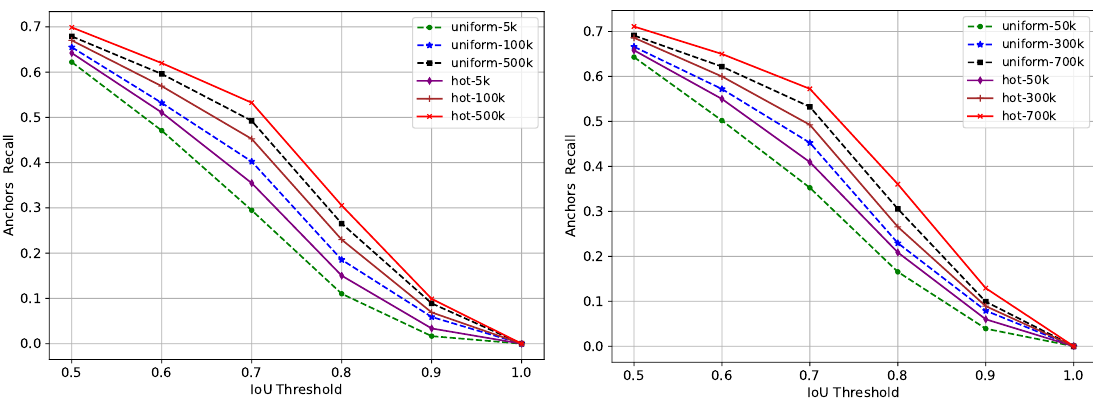
Figure 6. The recall of anchors with different IoU threshold. 1 k equals 1000. uniform refers to the uniform anchors and hot refers to the hot anchors. The number of sampling pixels is 1/9 of the number of anchors. We show the results in two separate figures ( A , B ) for clear observation in case the curves are too dense.